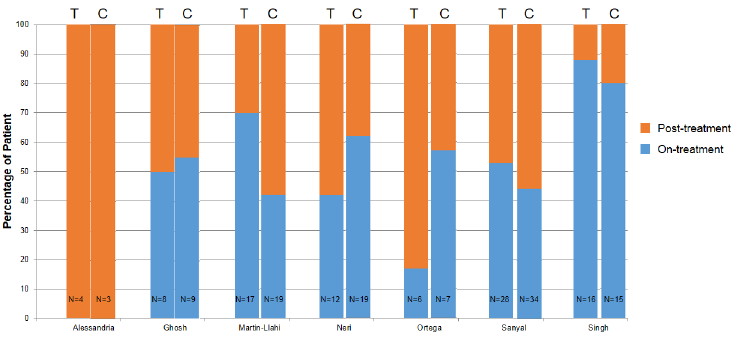
Fig 2. Proportion of Deaths Occurring During Intervention Period vs During Follow-up Period (Post- Treatment). Percentage of overall patients who died during the study period in the treatment arms (T) and the control arms (C) who died either while on treatment or during the post-treatment follow-up period. ” N ” indicates the total number of patients in each arm who